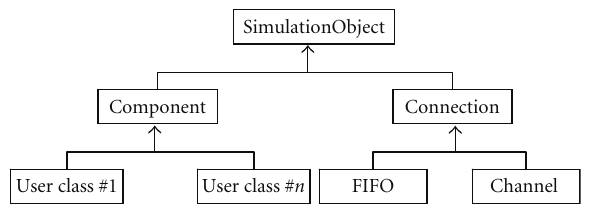
Figure 5: Class hierarchy of the modeling framework SmallSystem. In order to use simulation functionalities the framework SmallSys- tem inherits from the